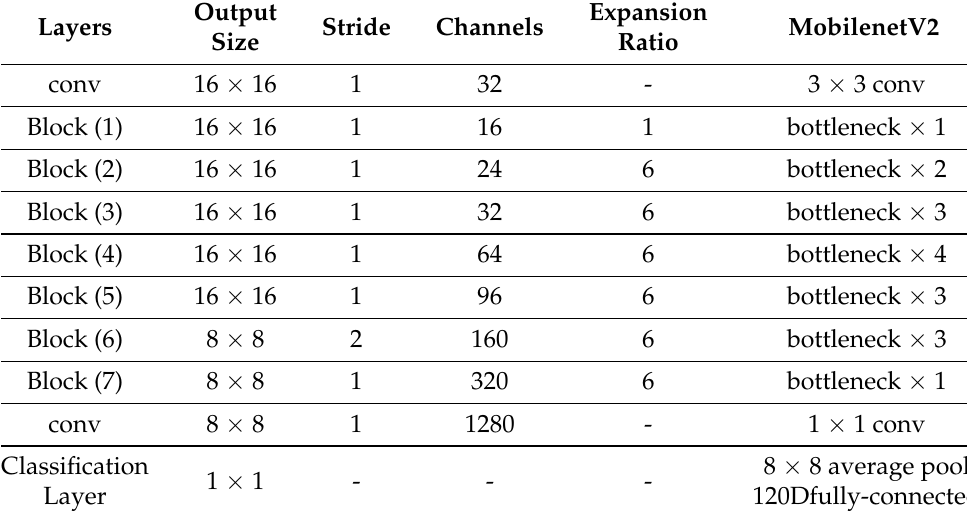
Table 4. MobileNetV2 architectures for ImageNet-16-120. In the table, bottleneck is